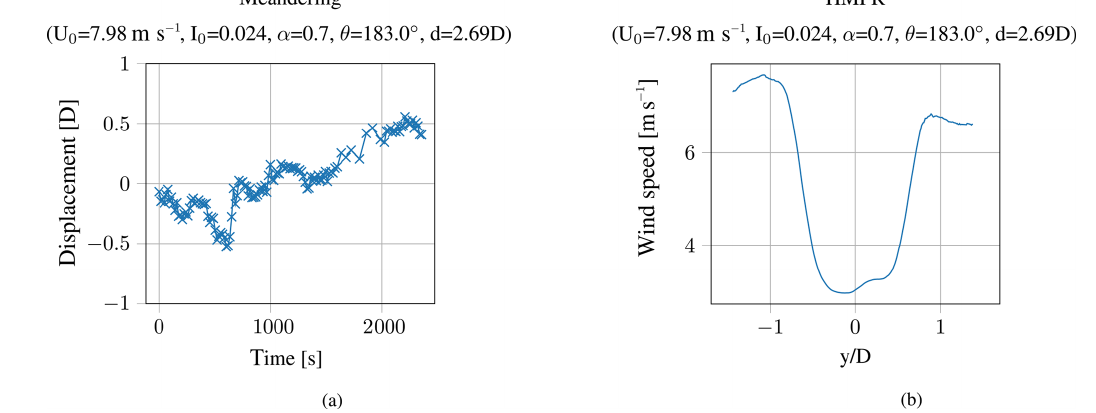
Figure A1. Meandering time series (a) and wind speed deficit in the HMFR (b) at 2 . 69 D downstream of the